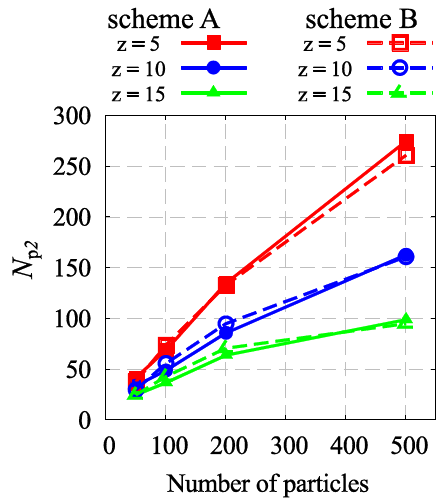
Figure 23. Number of passes of the multiple particles.